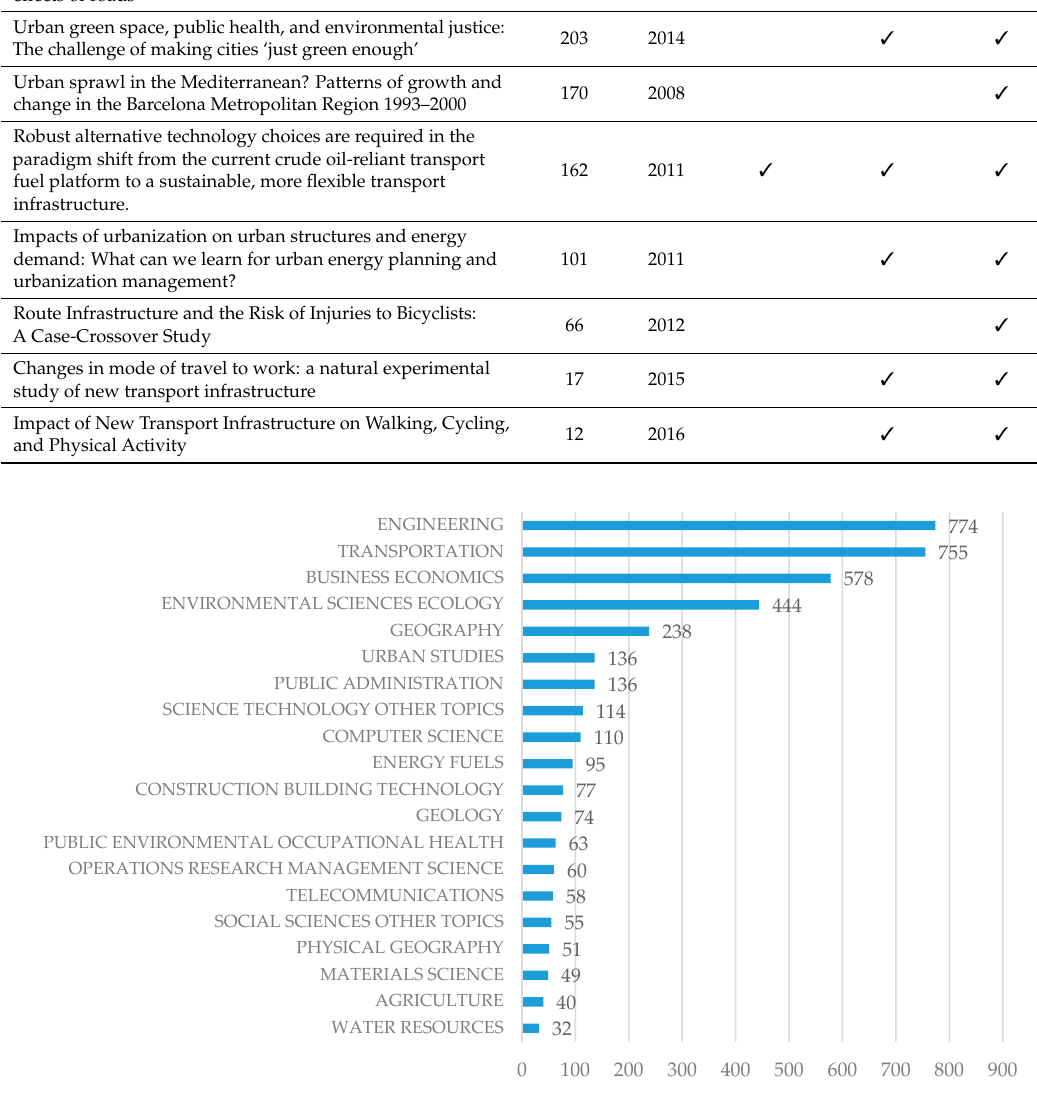
Figure 1. The top 20 research fields of the transportation infrastructure.